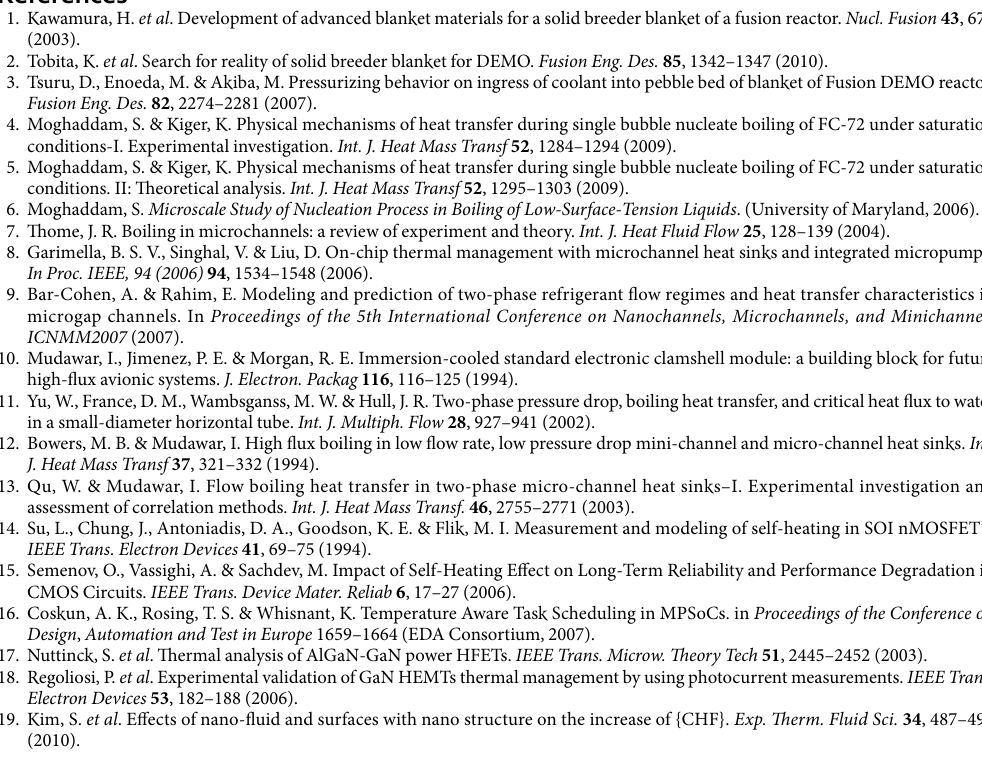
surfaces. This new degree of freedom in conjunction with a careful design of a set of surfaces with different wick- ability and heat transfer area enabled a better understanding of the CHF physics. The parameters influencing CHF were clearly identified and their relative impact was precisely quantified. It was demonstrated that CHF can be varied by tailoring the surface wickability, heat transfer area, and applied pressure, and each of these factors can limit the CHF depending on the surface structure design and heat flux level. It was shown that surface nat- ural ability to rewet itself (i.e. wickability) plays a key role at low heat flux. However, to reach high CHF levels, pressure-assisted re-wetting is required to overcome strong momentum forces generated at the bubbles-liquid interface. It was revealed that increasing the surface area can enhance CHF only when surface is sufficiently rewetted. This behavior was explained by showing the effect of liquid pressure on wickability length, where the wicking length was decreased by increasing the liquid pressure. It was argued that the thermal conductivity of the base material ultimately limits the CHF, as thermal effectiveness of surface structures decline, and diamond surface structure may enable a CHF of 7–8 kW/cm 2 . Considering that the effect of different surface properties on CHF are now explained, the results of this study may inspire alternative approaches to control bubble-liquid interfacial dynamics to enhance CHF.